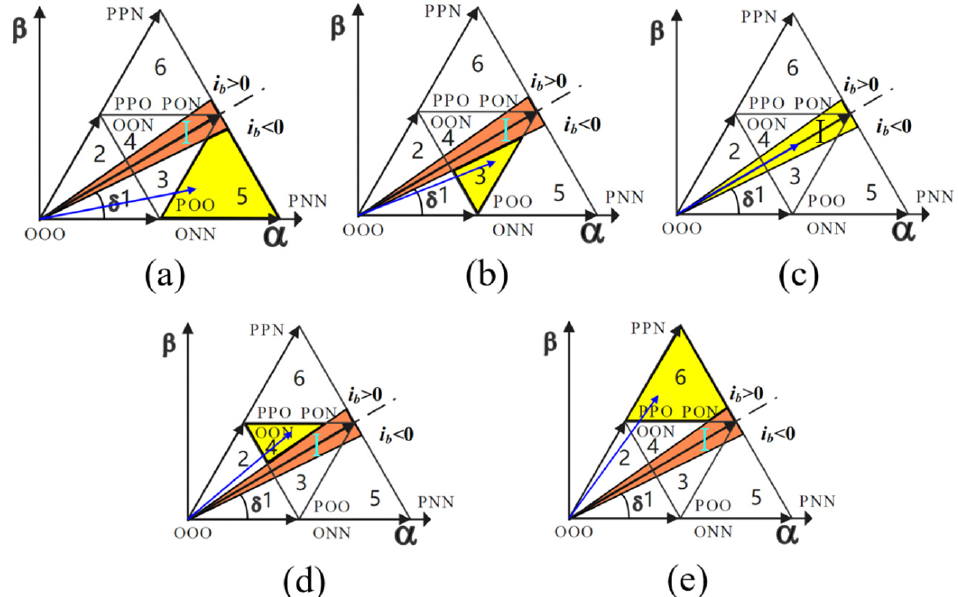
Figure 8. Operation of reference voltage vector in sectors 3, 4, 5, and 6. ( a ) The reference voltage vector is in the undistorted region of sector 5. ( b ) The reference voltage vector is in the undistorted region of sector 3. ( c ) The reference voltage vector is in the distortion region I. ( d ) The reference voltage vector is in the undistorted region of sector 4. ( e ) The reference voltage vector is in the undistorted region of sector 6. Table 2. Modulation method, clamping method, and corresponding switching sequence of different sectors.